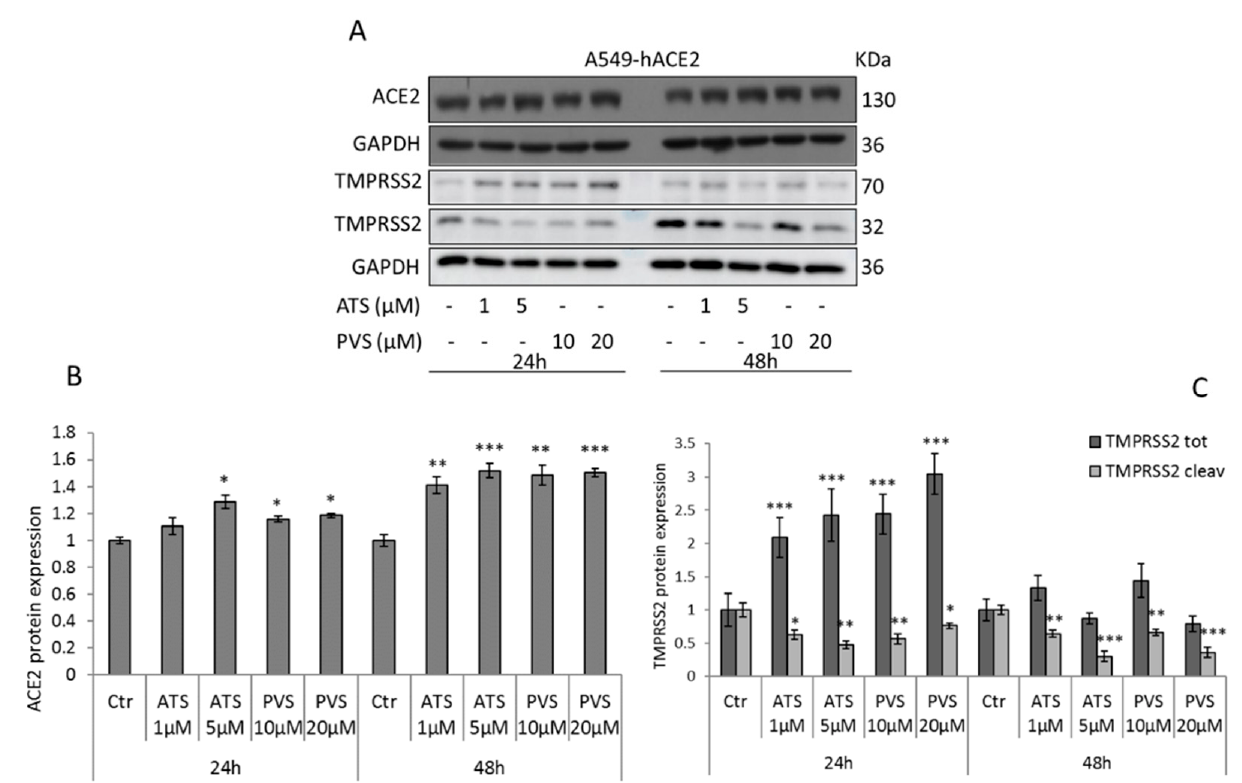
Figure 1. Representative Western blot and densitometric analyses of ( A , B ) ACE2 receptor and ( A , C ) TMPRSS2 (total and cleaved forms) expression in A549-hACE2 cells treated with ATS or PVS as indicated. GAPDH was used as loading control. Data are expressed as mean ± SD of at least three independent experiments. * p < 0.05, ** p < 0.01, *** p < 0.005 vs. control.